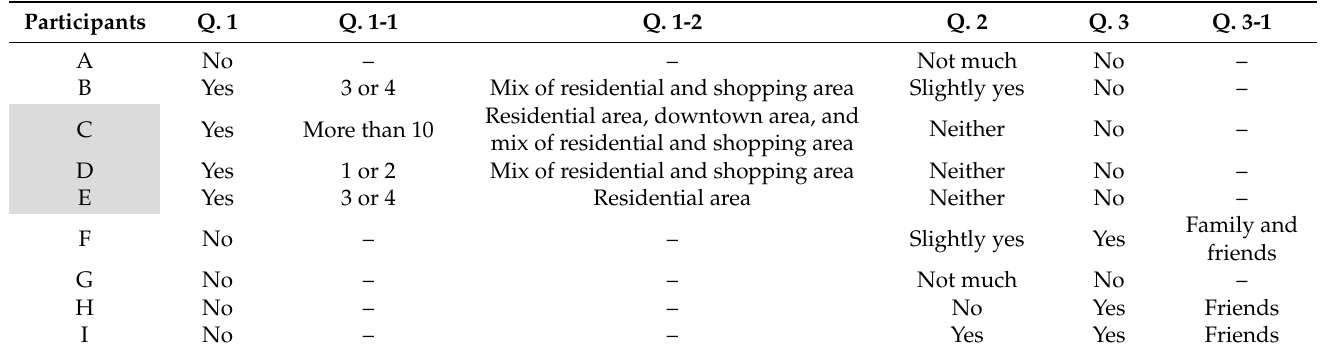
Table 2. Participants’ answers to the question items used in the follow-up